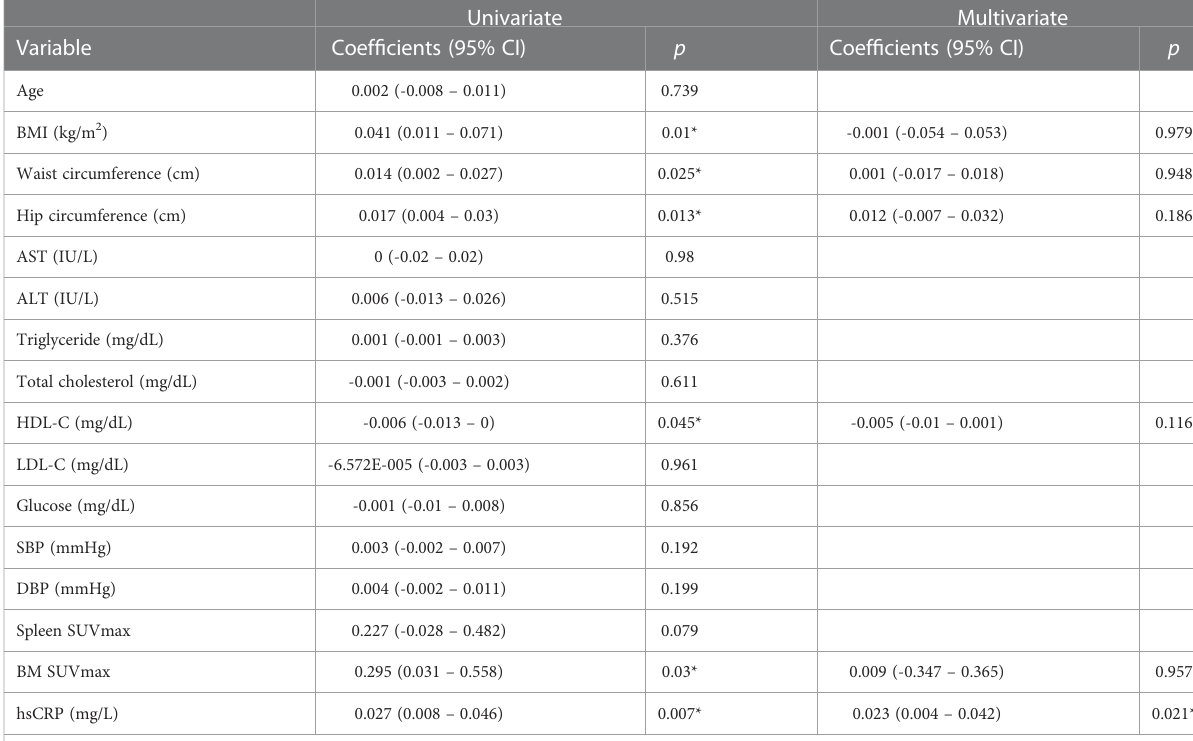
TABLE 3 Univariate- and multivariate analysis with AmygA as a dependent variable at baseline obese women